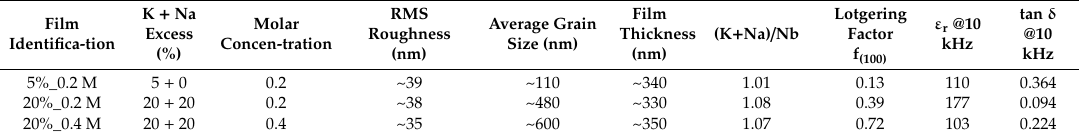
Table 1. Identification and properties of K 0.5 Na 0.5 NbO 3 (KNN) thin films deposited on platinized Al 2 O 3 substrates using three solution